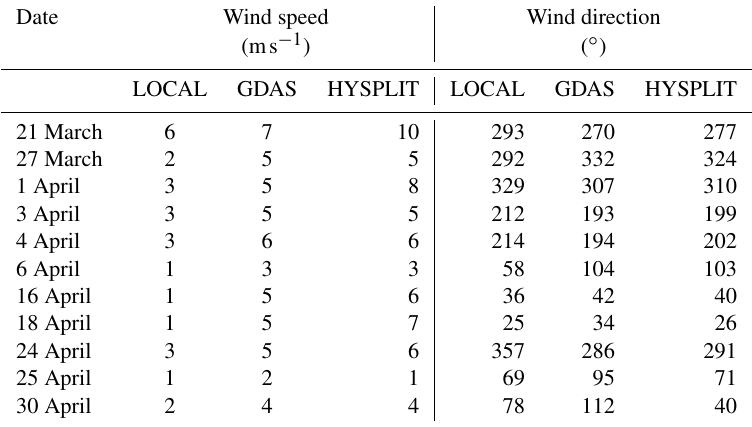
Table A3. The wind speed and the wind direction for the days of the field campaign, as retrieved from different data sources: in situ observations (LOCAL), globally gridded assimilated data (GDAS) and backward trajectory calculations